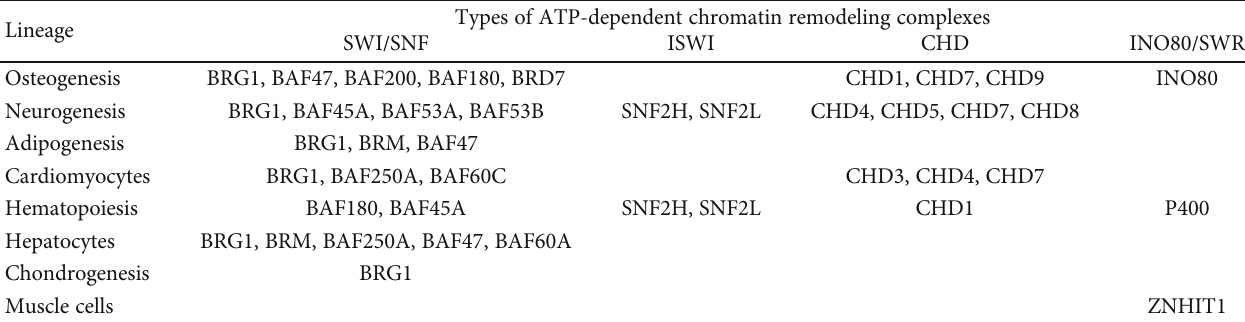
Table 1: Types of ATP-dependent chromatin remodeling complexes and their subunits in di ff erent lineage speci fi